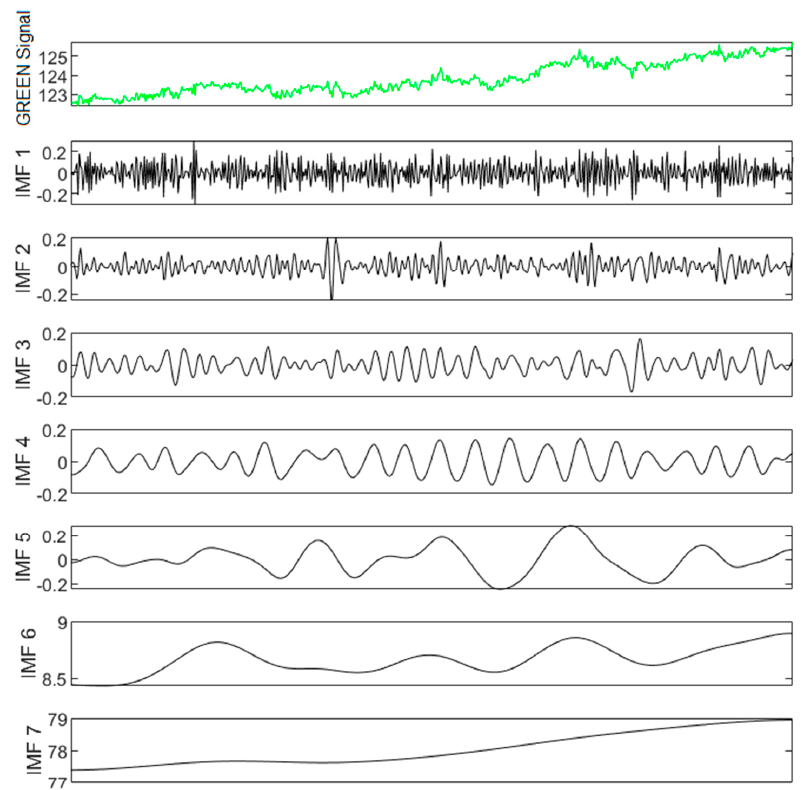
Figure 7. Signal decomposition of 𝐺 (cid:4666)𝑡(cid:4667) using a complete EEMD technique with 100 realisations and 100 iterations with 0.2 of noise standard deviation. 100 iterations with 0.2 of noise standard